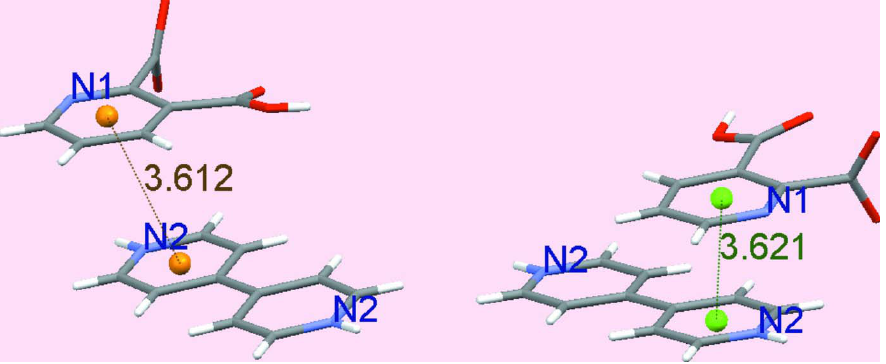
A view of the crystal packing diagram of the title compound with the hydrogen bonds shown as dashed lines.